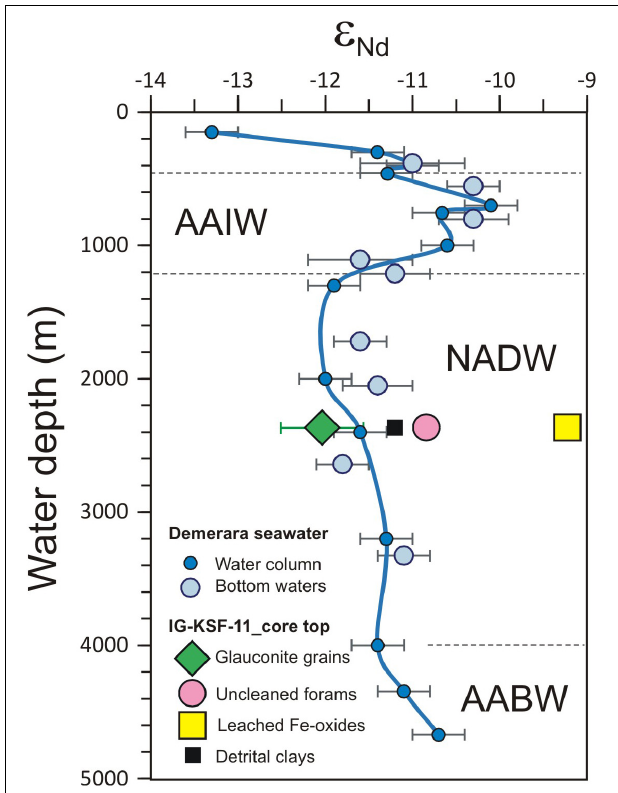
FIGURE 2 | The distribution of water masses and associated Nd isotope profile ( ε Nd ) along the water column at the Demerara Rise (after Huang et al., 2014). Comparative ε Nd values for core-top foraminifers, glauconitic grains, terrigenous clays, and Fe-Mn oxyhydroxide phases in core IG-KSF-11 are shown for